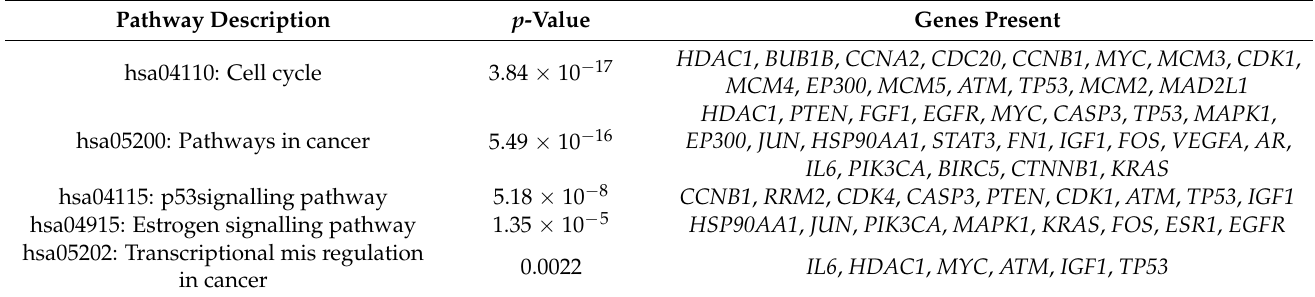
Table 3. Top five pathways identified by KEGG tool from the TNBC subnetwork.